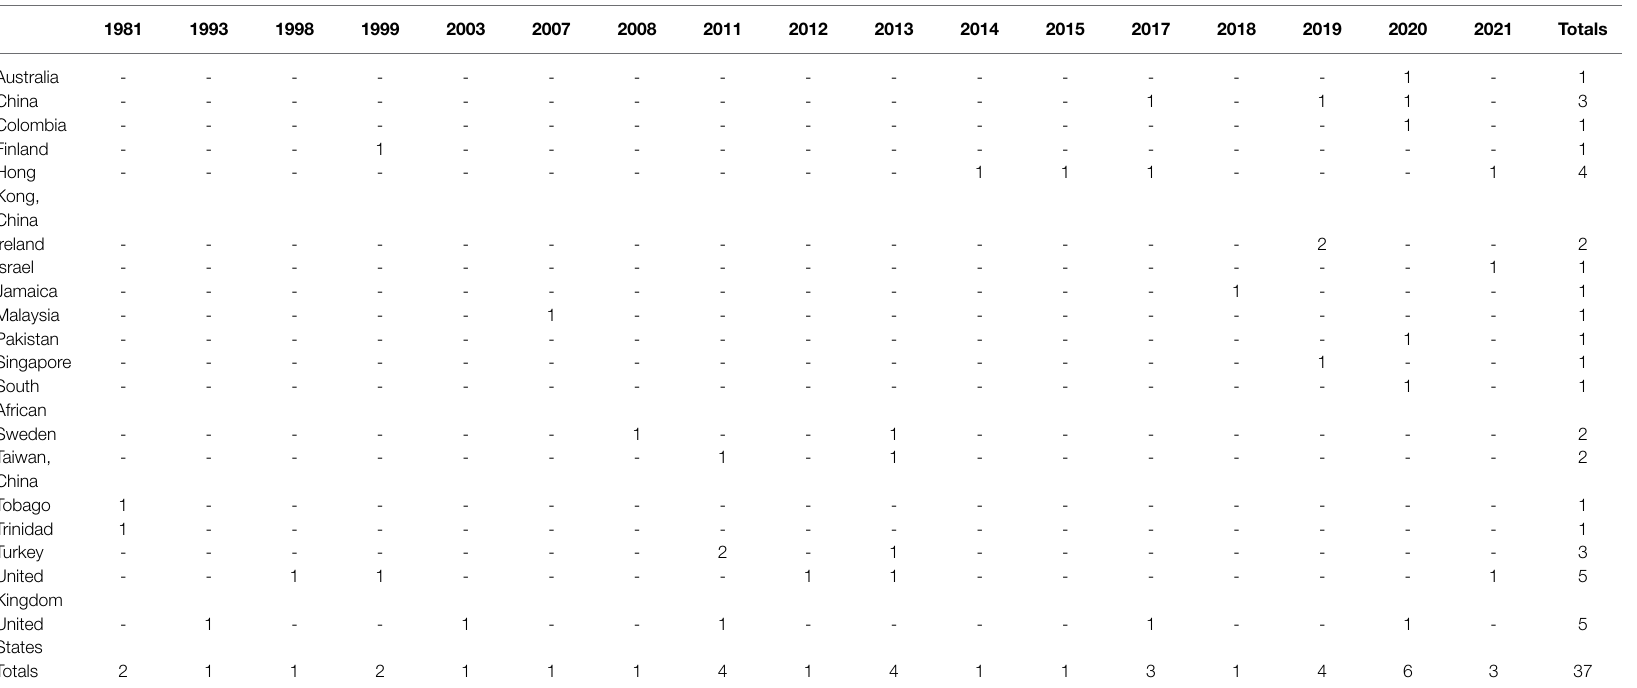
TABLE 3 | The distribution of articles according to country.